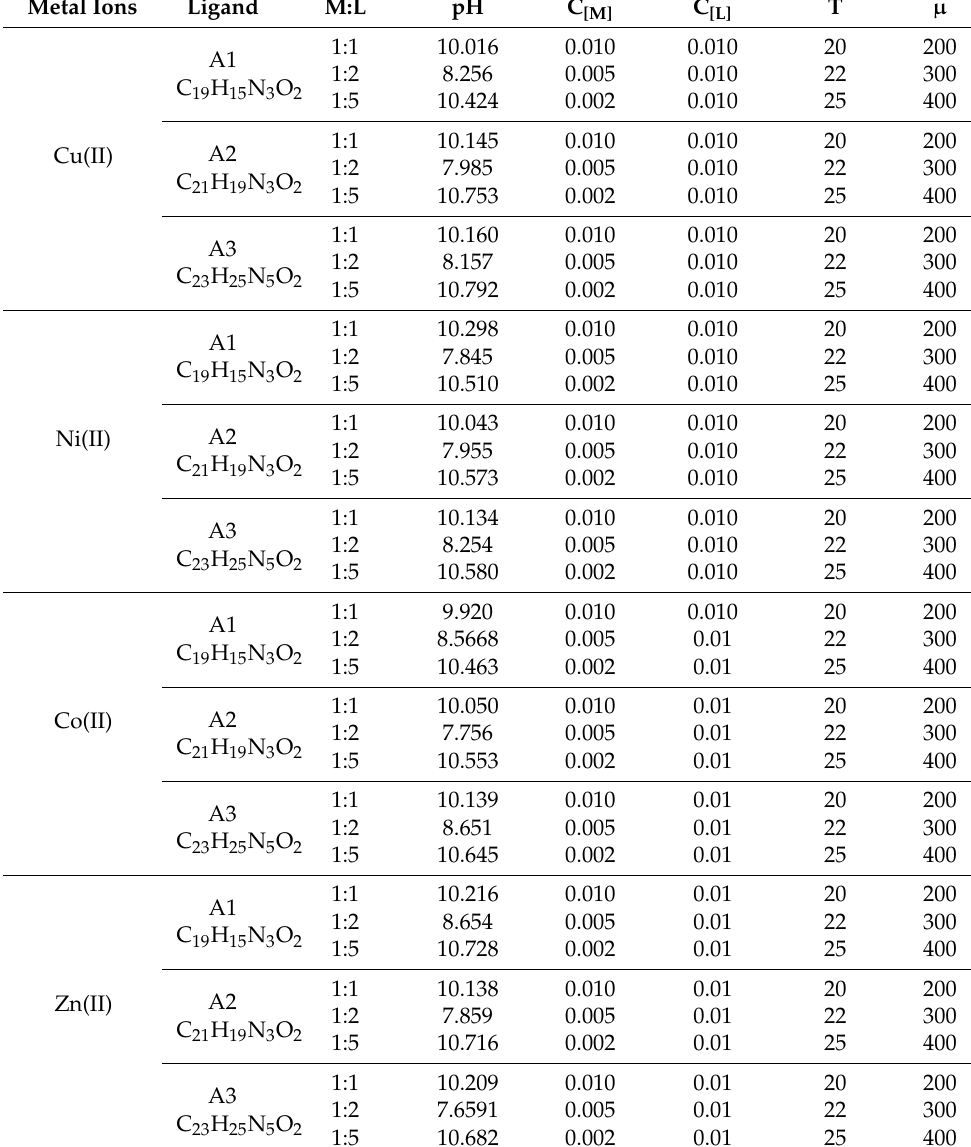
Table 2. The parameters of classic solvent extraction processes. Metal